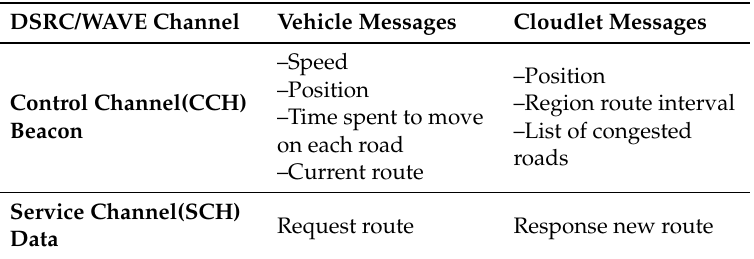
Table 2. Data exchange by DSRC/WAVE communication